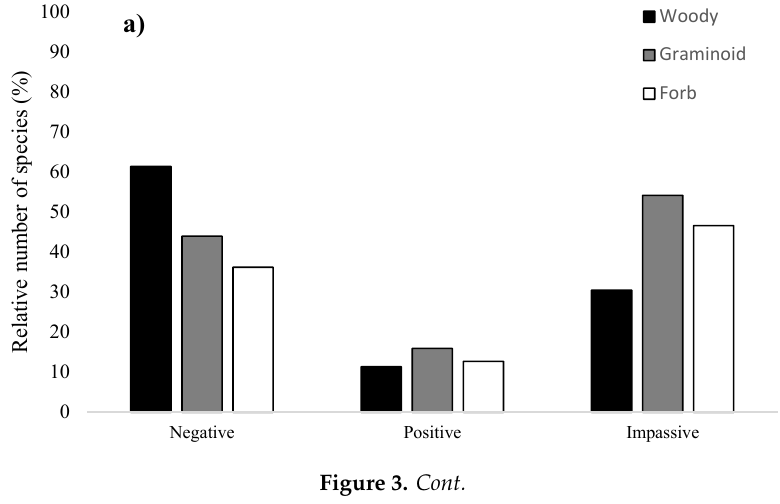
Figure 3. Cont . Figure 3.